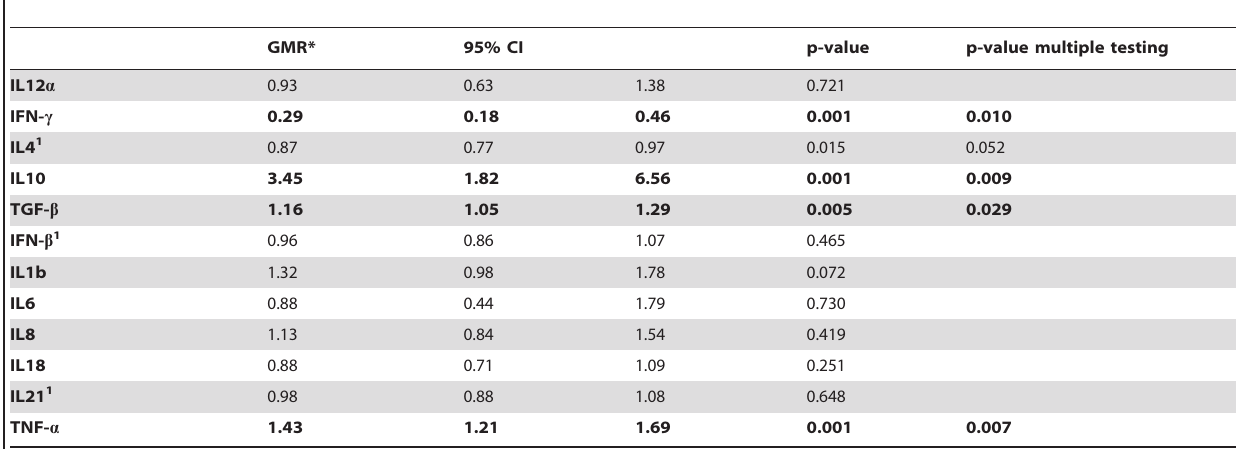
Table 5. Association of farm life with the expression of cytokine